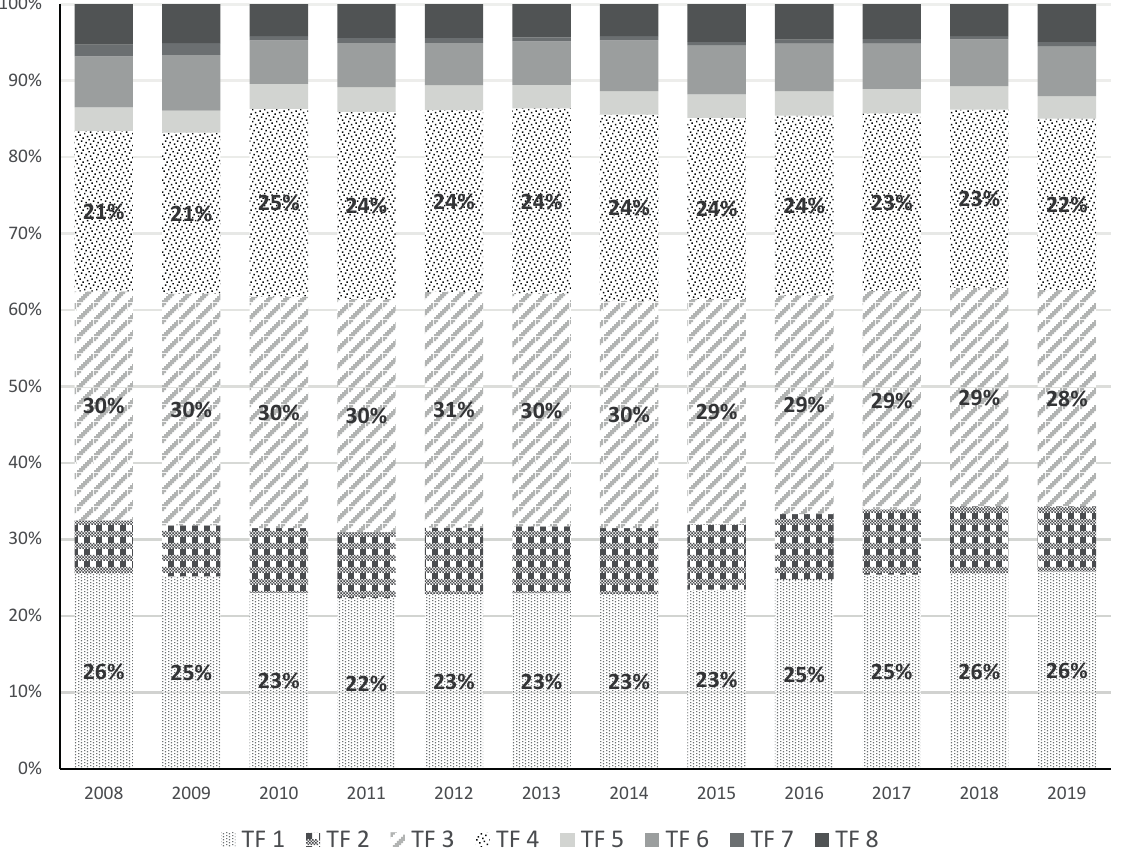
Figure 8. Evolution of the Type-of-Farming (TF) categories over the 2008-2019 period within the Italian FADN balanced sample (% is indi- cated only for FT >10%,). Legend: TF1 = Field crops; TF2 = Horticulture; TF3 = Permanent crops; TF4 = Grazing livestock; TF5 = Grani- vores; TF6 = Mixed crops; TF7 = Mixed livestock; TF8 = Mixed